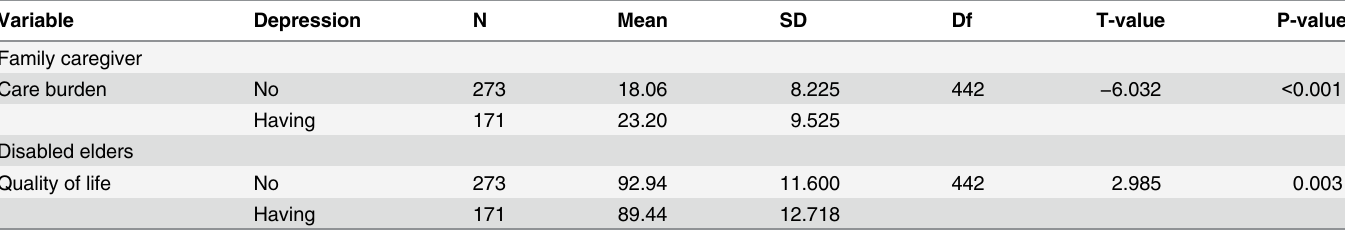
Table 5. Tests of independent means in comparing effects of the lack and presence of depressive emotion on the care burden of informal caregiv- ers and quality of life of disabled elders.